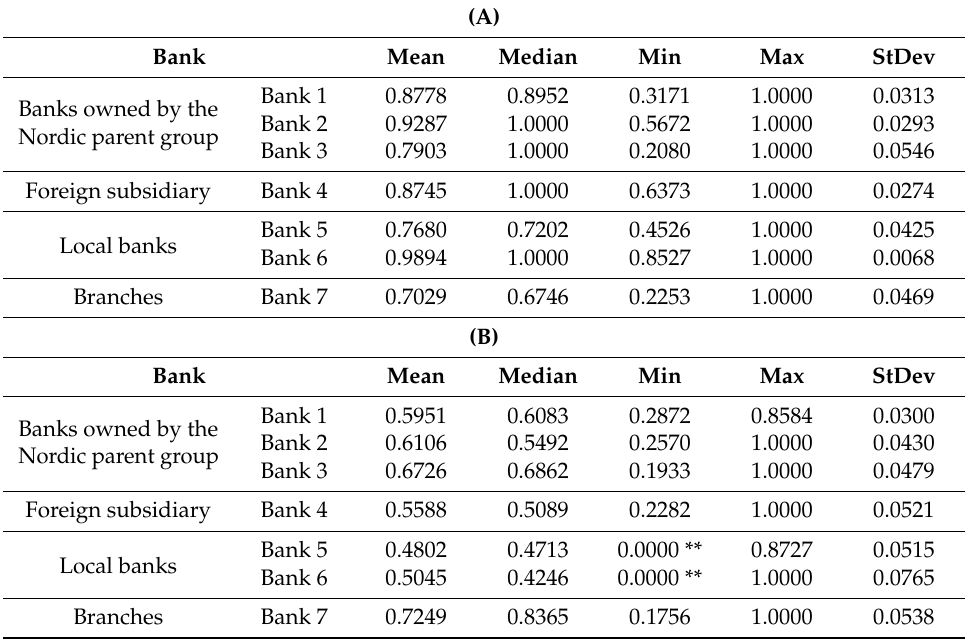
Table 3. Efficiency of Lithuanian banks calculated with M1–M5 models (respectively VRS (A) and CRS (B) assumptions): descriptive